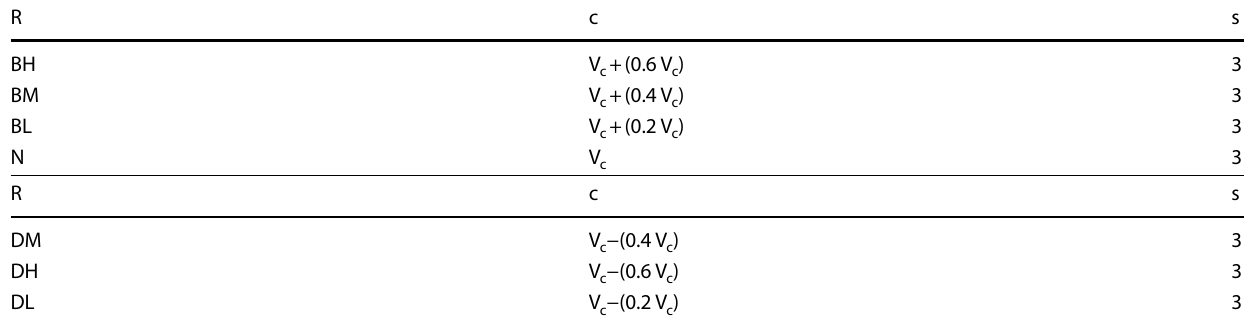
Table 6 Mean and standard deviation values for different response linguistic variables